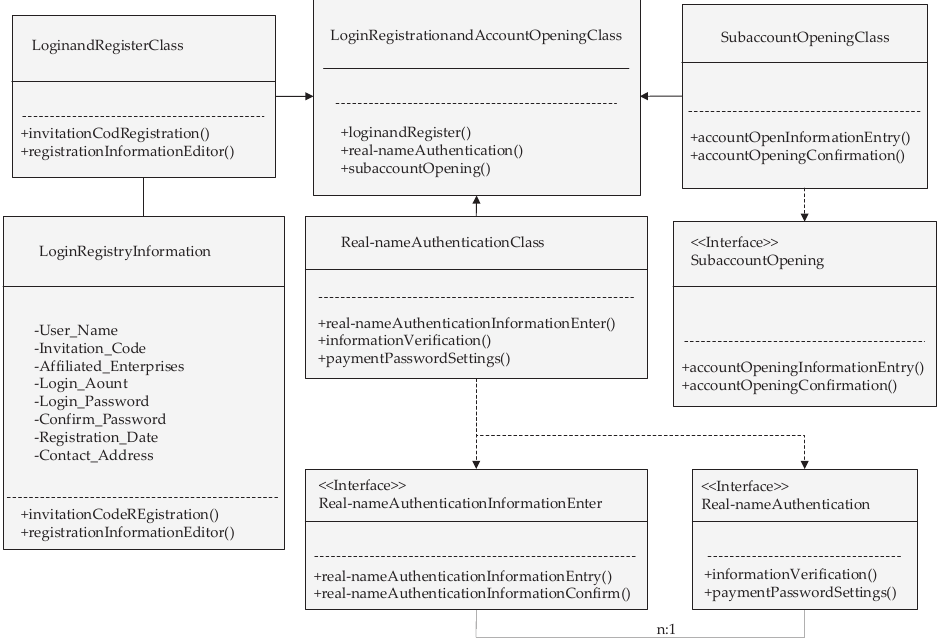
Figure 7. Class diagram of login registration and account opening